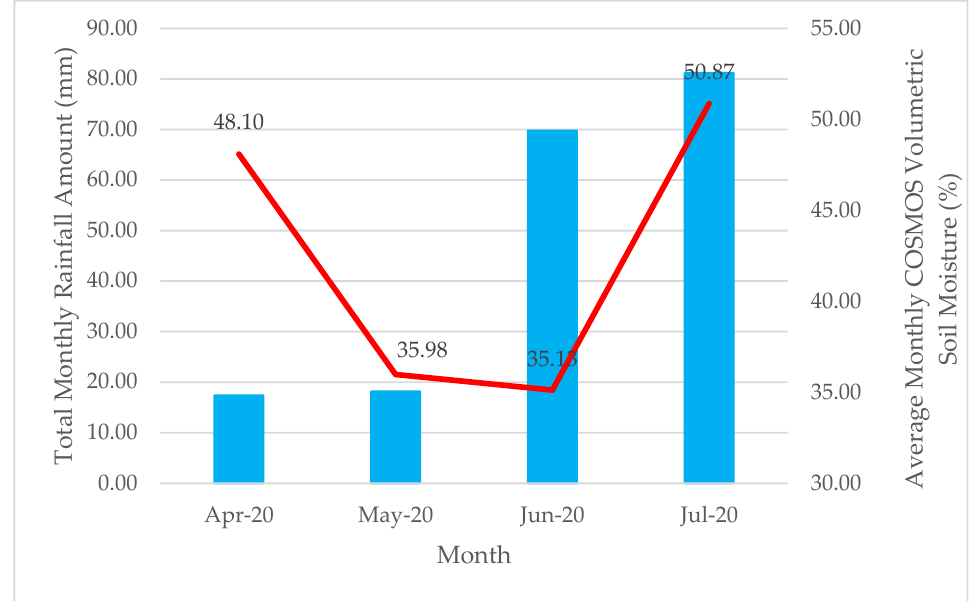
Figure 5. Total Monthly Rainfall Amount (mm) and Average Monthly COSMOS Volumetric Soil Moisture content (%) from April 2020 – July 2020.